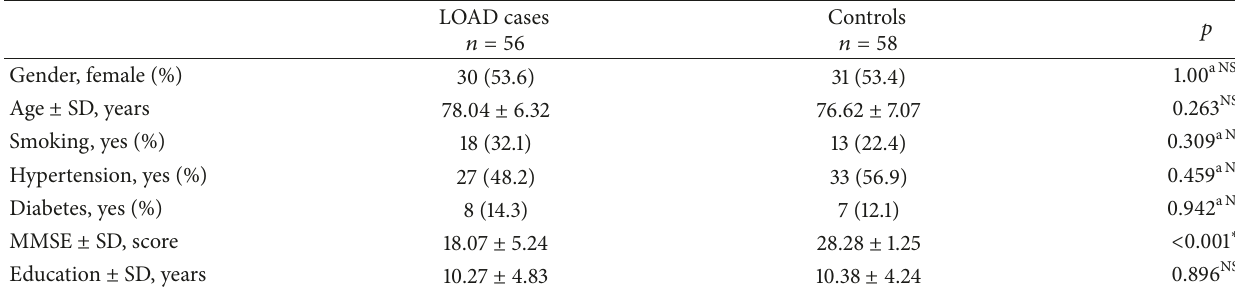
Table 1: Demographic and clinical characteristics.